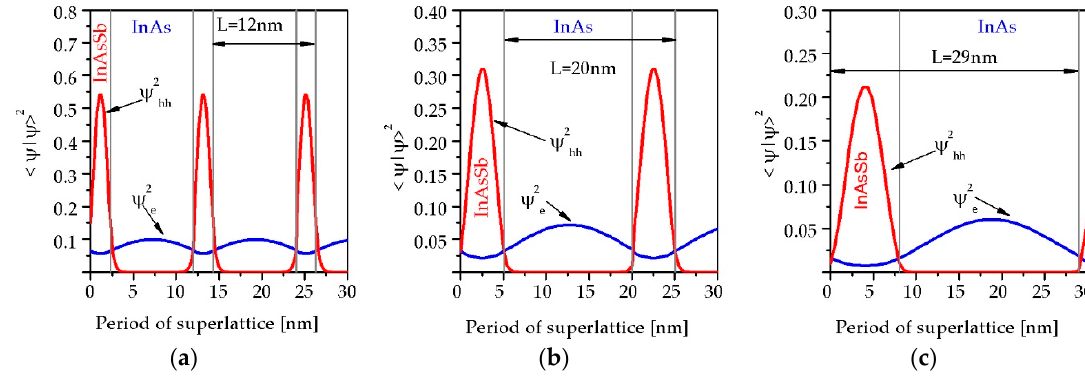
Figure 4. Electrons and heavy holes probability distribution for InAs/InAsSb SL structures at 230 K for the SL period: ( a ) 12 nm; ( b ) 20 nm; ( c ) 29 nm.